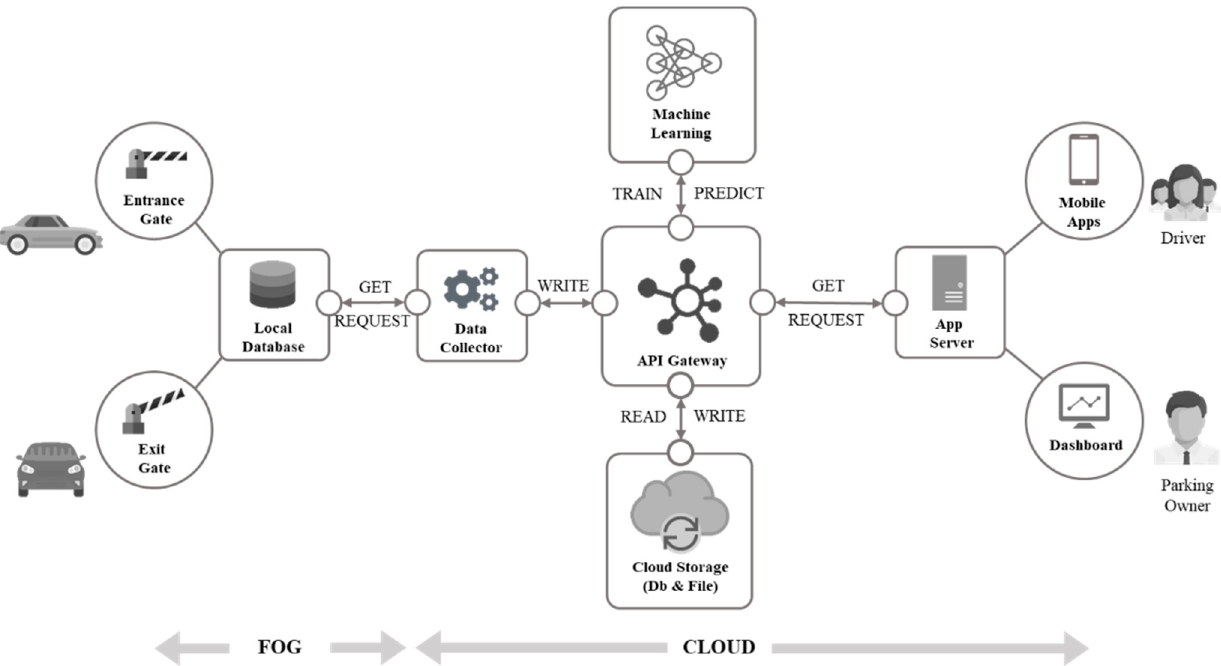
Figure 6. Cloud-based architecture system.